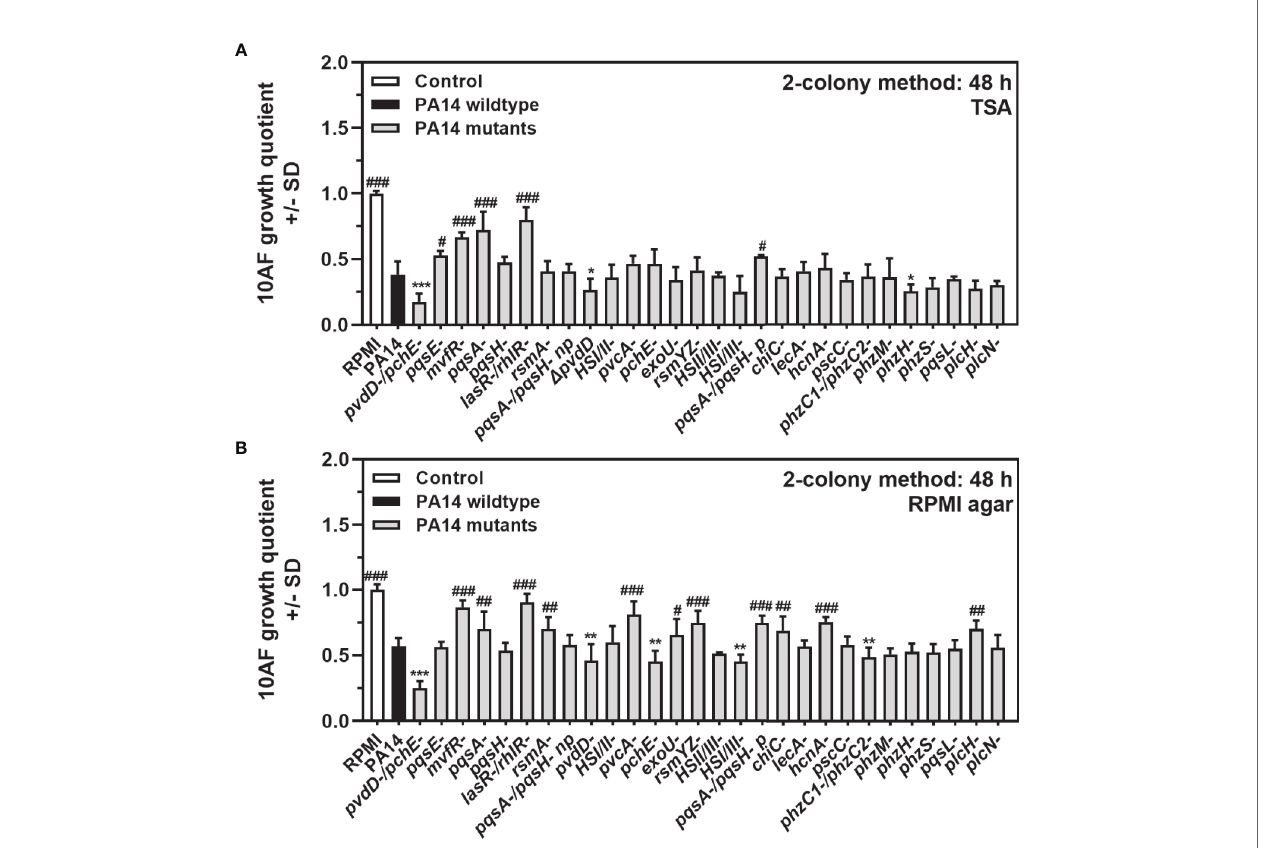
FIGURE 3 | Comparison of antifungal activities of P. aeruginosa PA14 mutants under coculture conditions on agar. (A, B) Six-millimeter paper disks were placed on RPMI agar. Ten microliters of A. fumigatus 10AF conidia (10 7 /ml, prepared in RPMI) was placed on each disk, and 10 µl of PA14 wild-type or 28 mutant bacteria (10 9 /ml, prepared in RPMI) was placed 15 mm distant from the disks carrying 10AF. Plates were incubated for 48 h at 37°C, and growth quotients were determined. Experiments were performed on TSA (A) and on RPMI agar (B) . Comparison: PA14 (black bar) vs . all other bars. Statistical analysis, t-test: one, two, or three asterisks or pound signs = p ≤ 0.05, p ≤ 0.01, and p ≤ 0.001, respectively. Asterisks represent signi fi cant increases in antifungal activity; pound signs represent signi fi cant